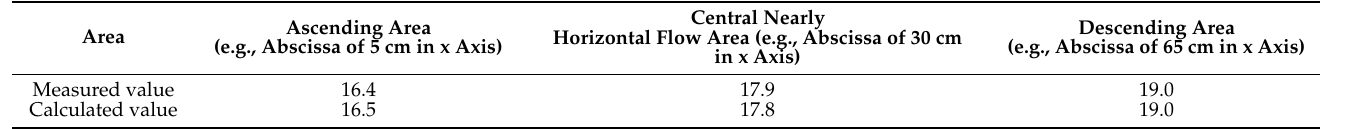
Table 3. TSZ thickness for each